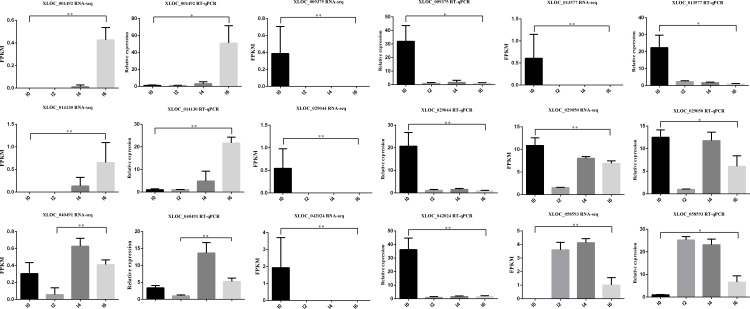
Validation of differentially expressed lncRNAs by qRT-PCR.*P<0.05, **P<0.01.